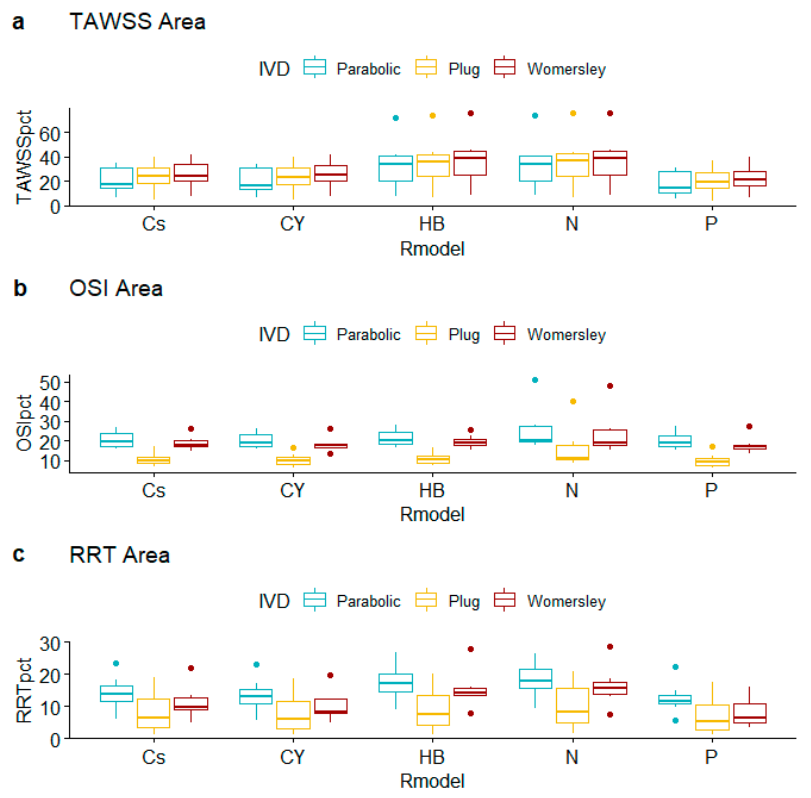
Figure 6. Boxplots of thrombogenic region percentages for alternative rheological models and inlet velocity distributions.